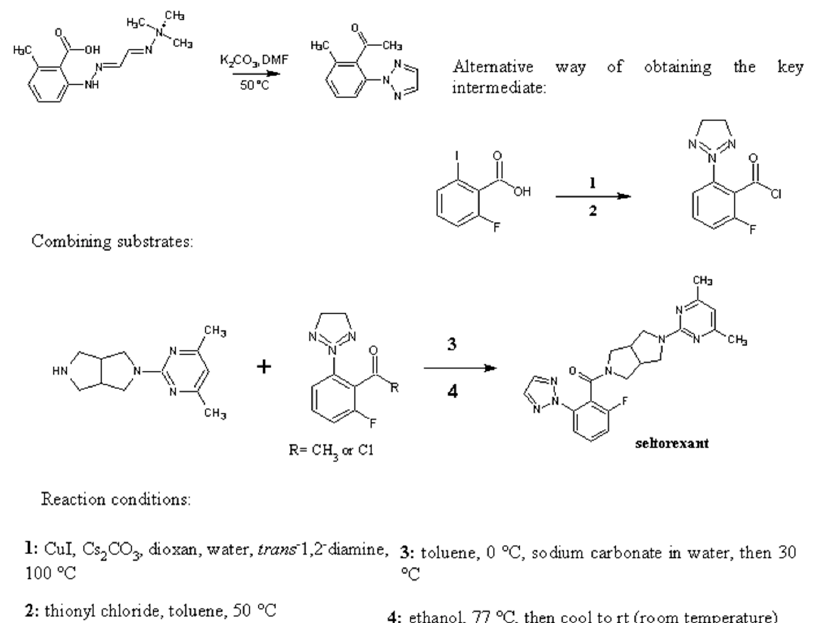
Figure 3. Possible methods of obtaining seltorexant, otherwise known as JNJ-42847922. Reactions adapted from Letavic et al., 2015 and Chen et al., 2020